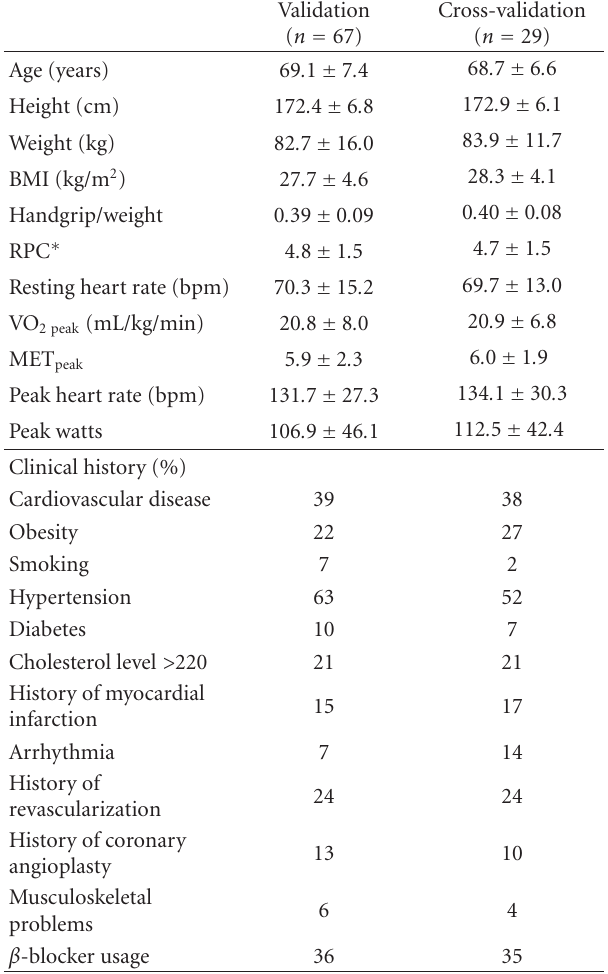
Table 1: Subjects’ characteristics (validation and cross-validation groups).